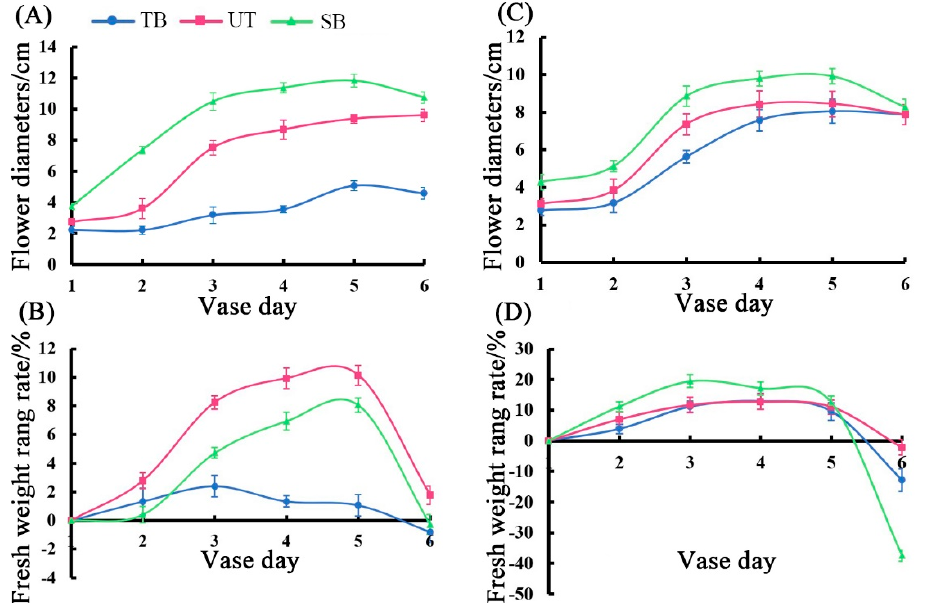
Figure 2. Flower physiological characteristics of in different harvest stages of “open-top type” cut P. lactiflora . ( A , C ) Flower diameter change and fresh weight change rate of ‘Dan Feng’ in three harvesting stages during vase. ( B , D ) Flower diameter change and fresh weight change rate of ‘Lu Xihong’ in three harvesting stages during vase. TB, tight-bud; UT, unfold-top; SB, soft-bud. Values are expressed as the mean ± SD of triplicate assays. Vertical bars represent the standard deviations of the means.